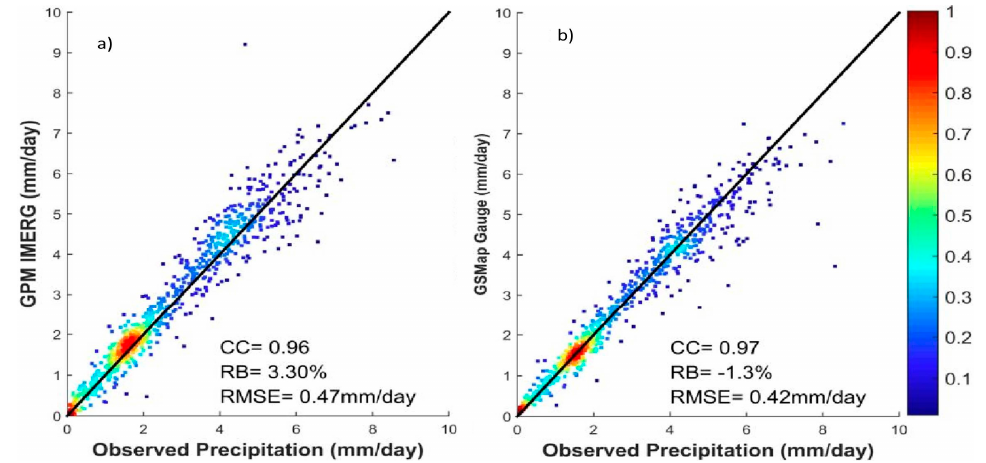
Figure 5. Density-colored scatterplots of the various products, ( a ) GPM IMERG; ( b ) GSMap-Gauge, against the 840 observed precipitation gauge stations. The dark solid line is the 1:1 line of total agreement. The color represents the occurrence possibility and red indicates that a high percentage of total points are located in that area.